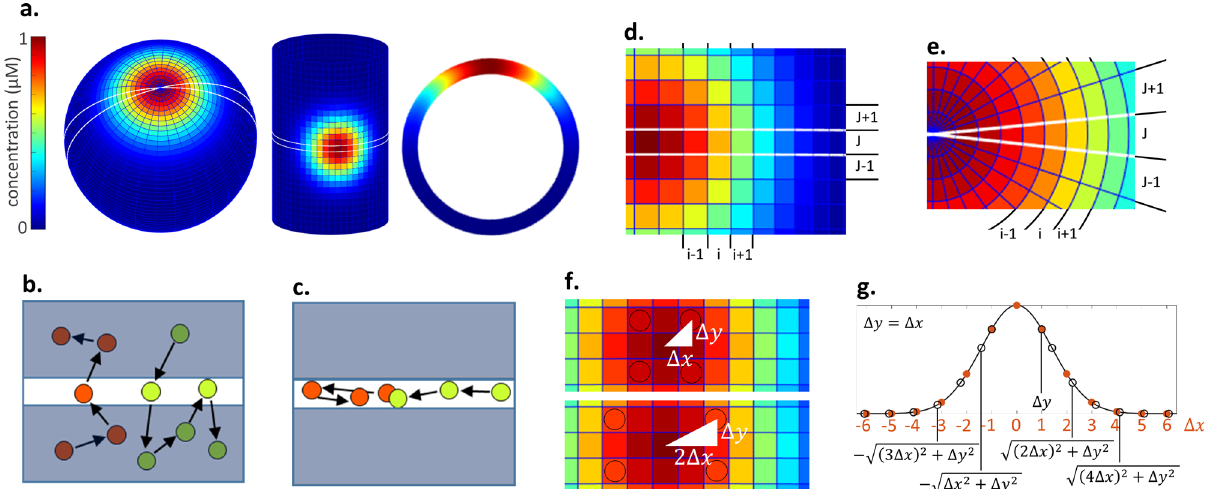
Fig. 1 Dimension reduction. a Dimension reduction example showing a polarity patch on a spherical cell and body of an elongated cell with their reduced- dimension model representation, a stripe on a ring. White lines on 2D surfaces show the focal plane. b Molecules on a 2D surface moving through the focal plane. The focal plane is shown as a white stripe. c Molecules in a reduced-dimension model are restricted to the focal plane (white stripe). d Regular mesh over a polarity patch on the body of an elongated cell, the zero- fl ux assumption is not satis fi ed. e Spherical mesh over a polarity patch on a spherical cell. The zero- fl ux assumption is satis fi ed, u τ i ; J ¼ u τ i ; J ¼ u τ i ; J . f Regular mesh over a polarity patch on the body of an elongated cell. Distances from the centre (cid:2) 1 þ 1 of the patch of each point in rows J ± 1 found using Pythagoras (white triangles and text). Concentrations in circles are the same because of radial symmetry. g Using interpolation (black line) on the concentrations in the focal plane (orange dots) to estimate e u τ i ; J (black open ± 1